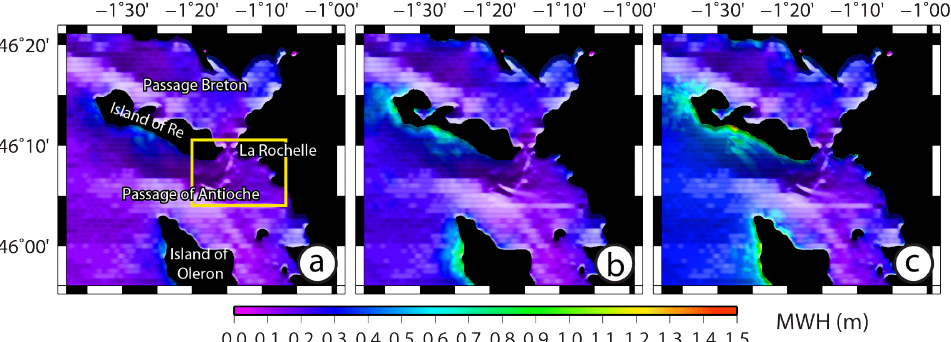
Figure 9. Maximum wave height maps obtained after 12h of propagation showing coastal amplifications close to the coastal town of la Rochelle (grid 7) for the 3 scenarios. From left to right, scenarios 1 (a) , 2 (b) , and 3 (c) . The yellow rectangle shows the position of the following grid 8.